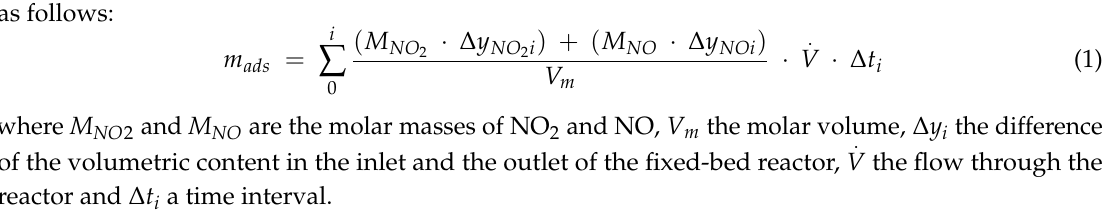
Figure 8. Breakthrough curves of NO through three differently activated sorbent samples made from olive stones (c 1 NO 2 = 5 ppm, c 1 NO = 0 ppm, 23 °C, 50% RH, v = 0.2 m/s, m Sorb = 2 g).